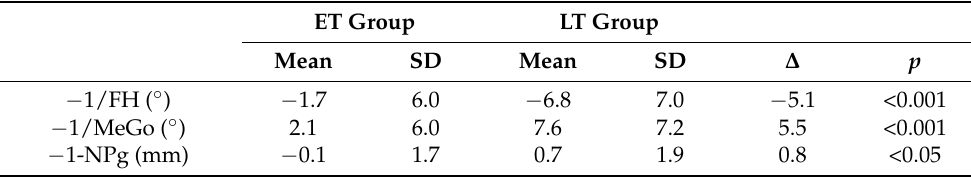
Table 4. Lower incisors changes in NonEx Patients (intentional proclination for space regain